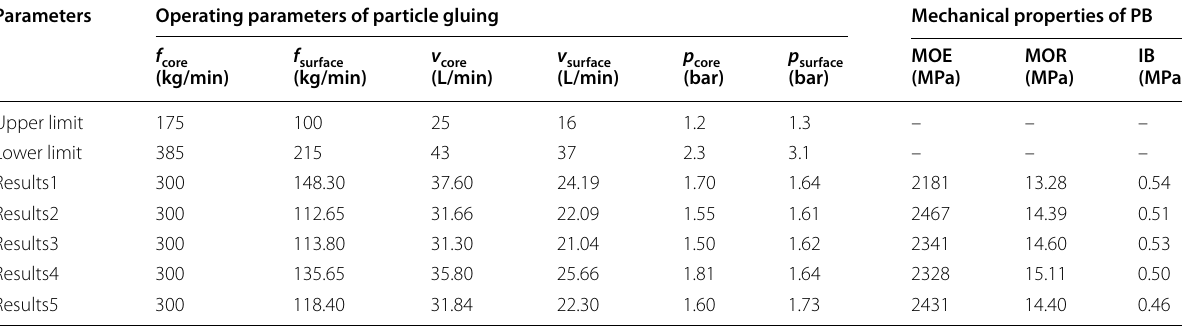
Table 5 Multi-objective optimization sets of MOE, MOR and IB Parameters Operating parameters of particle